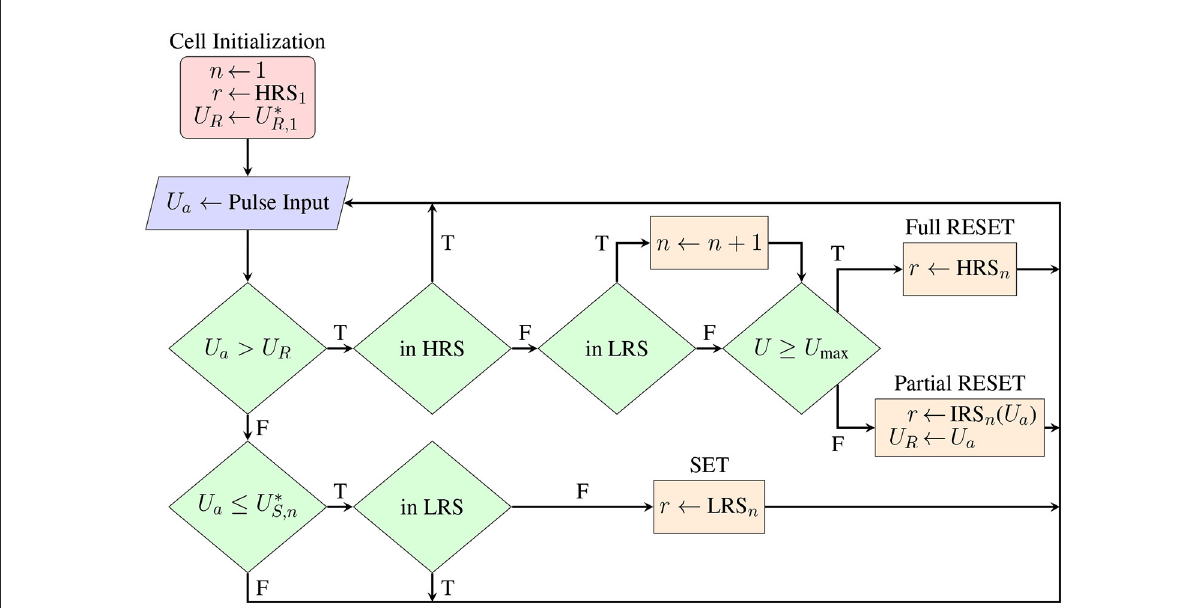
FIGURE11 Logical flow chart showing how applied voltage pulses affect the state of each cell during simulation. Following the experimental observations, SET processes always occur abruptly below a threshold voltage, while partial switching is induced for a range of RESET voltages, with intermediate states bounded for cycle n by resistance values between R L , n and R H , n stochastic driving process are used for limiting resistance states and threshold voltages. Pulse amplitudes not producing a state change are efficiently